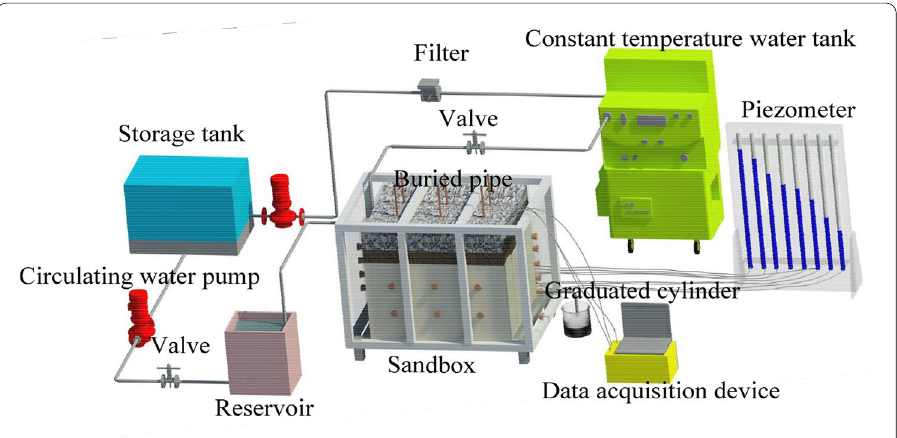
Fig. 3 Schematic diagram of the experimental